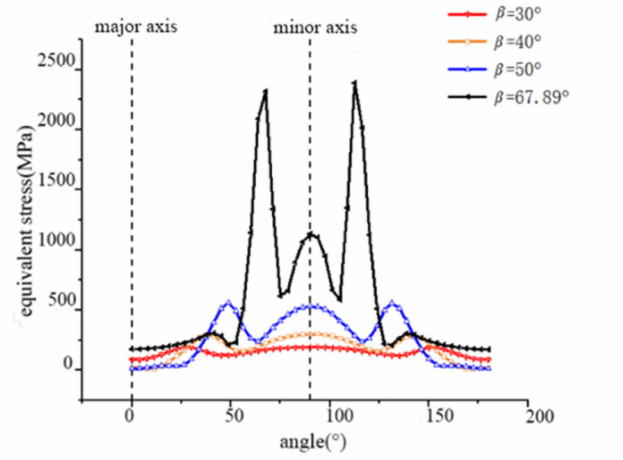
Figure 7. Equivalent stress with wrap angle from 67.89 ◦ to 30 ◦ .